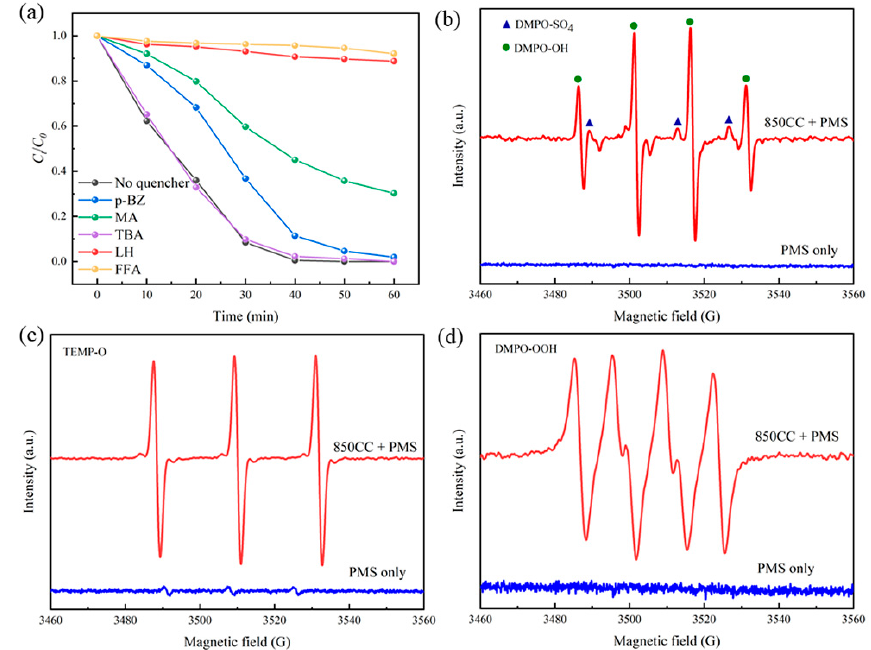
Figure 7. Effects of the radical scavengers on RhB degradation in the 850CC/PMS system ( a ) and EPR spectra of trapped radical adducts in different systems ( b – d ).